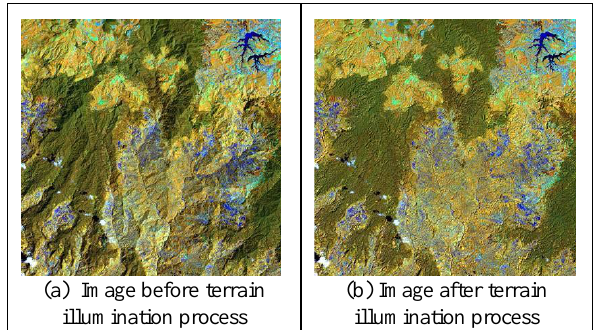
Figure 4. Sample image area from West Java before and after the terrain illumination correction. Bands 4, 5, 3 shown in